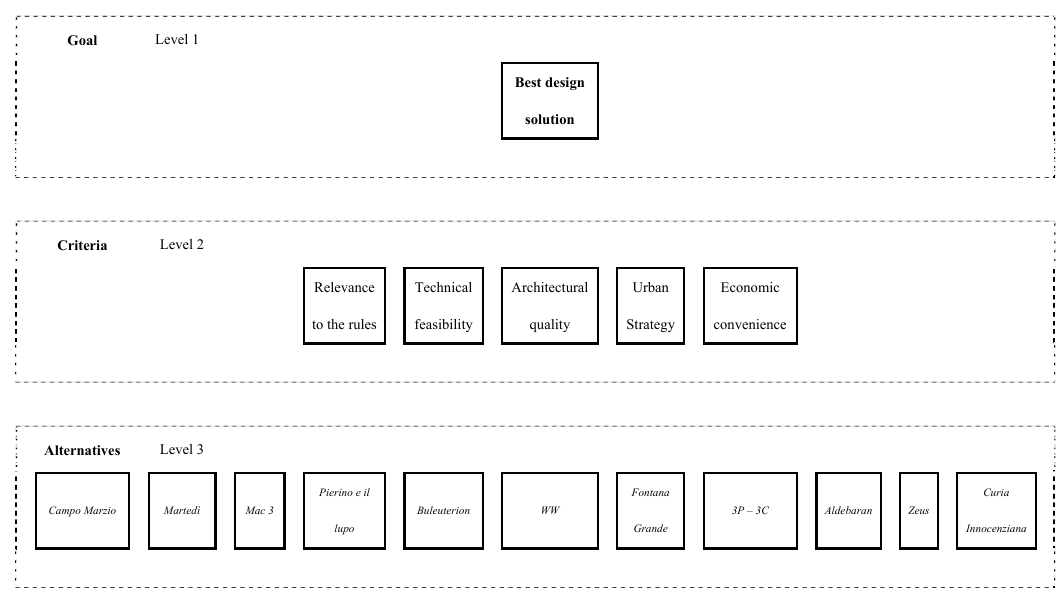
Figure 2. Structuring of hierarchy.